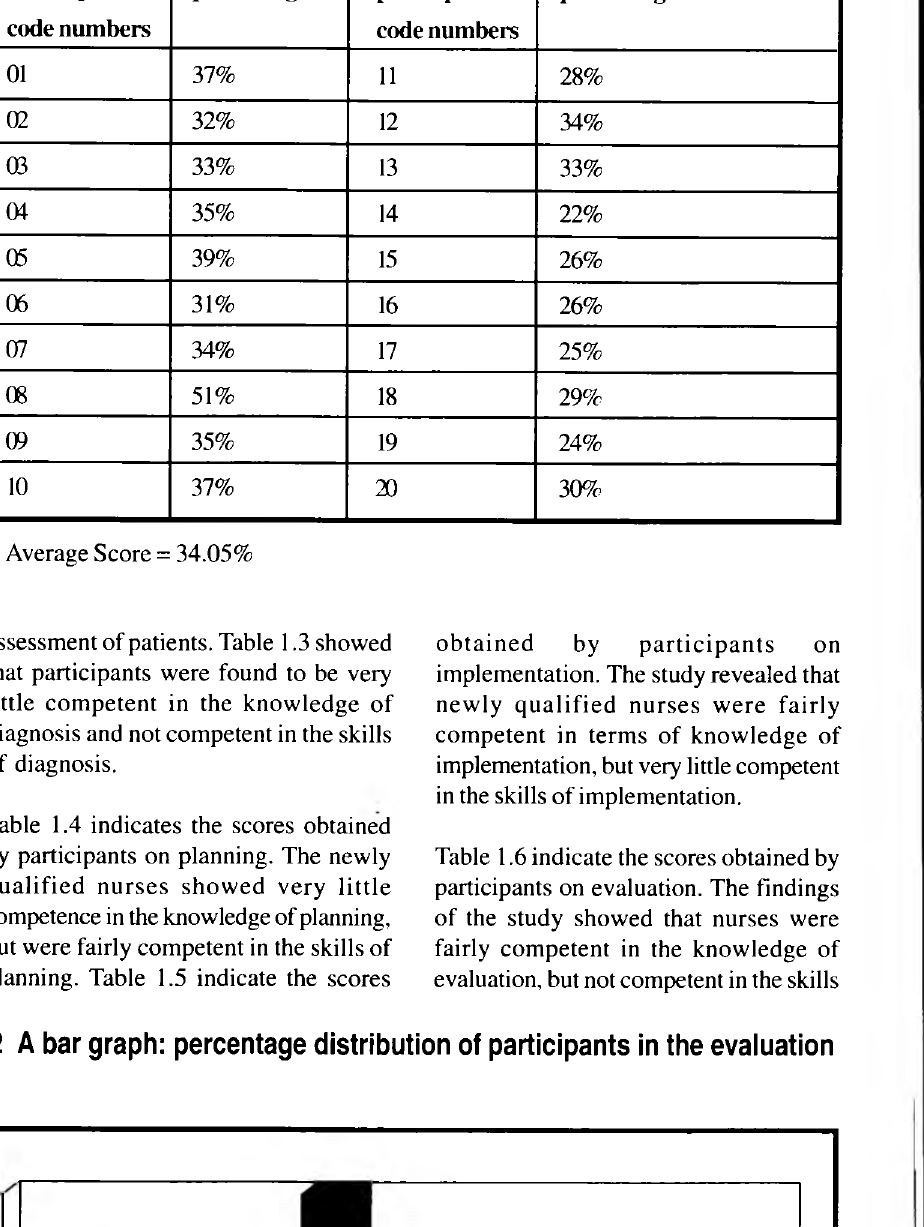
Figure 1.2 indicates the mode of 32 - 36% occurring seven times in the data set.